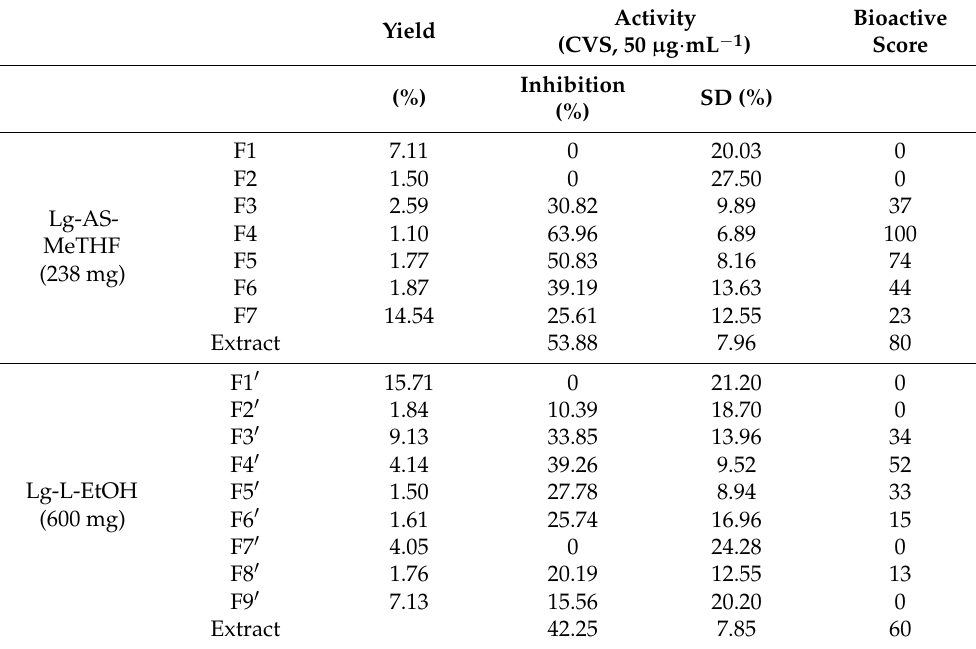
Table 2. Yields, antibiofilm activity and bioactivity scores calculated for L. grandiflora Lg-AS-MeTHF and Lg-L-EtOH fractions and crude